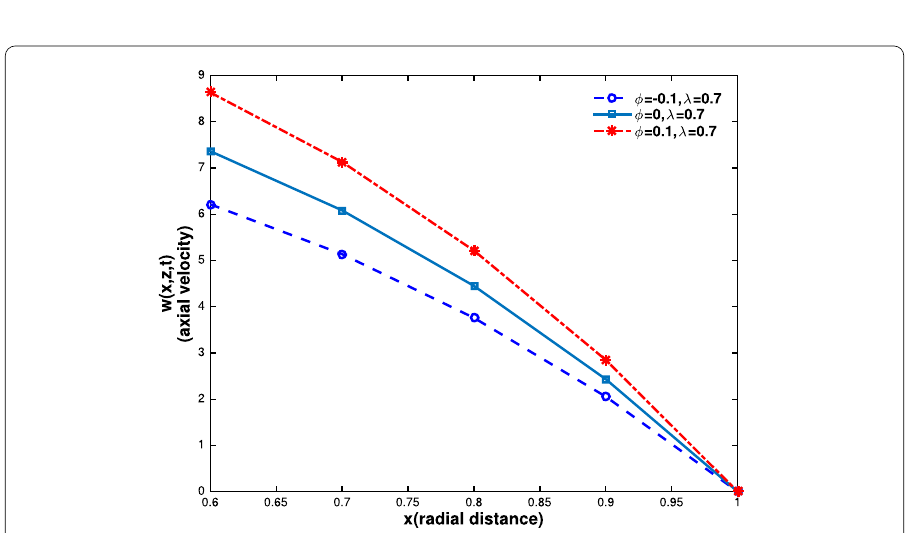
Figure 11 Axial velocity vs radial distances for φ = –0.1,0,0.1 at z = 28, t = 0.45, τ y = 0.4, K = 1.6, λ =